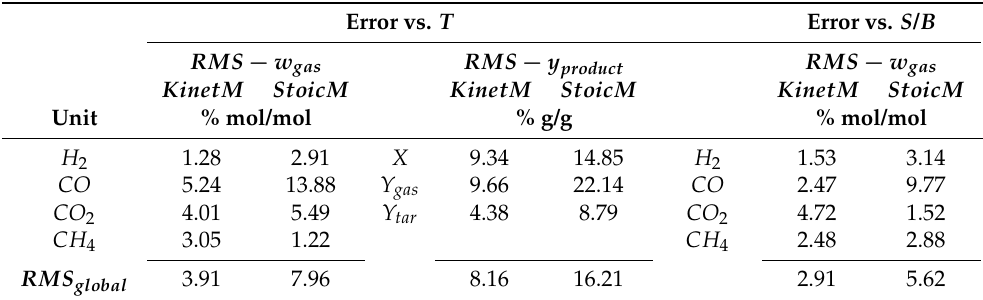
Table 7. The errors RMS of models StoicM and KinetM in the prediction of the syngas composition ( w gas , i ) and mass yield of the products ( y product , i ) when evaluating T and S / B . Error vs. T Error vs. S / B RMS − w gas RMS − y product RMS − w gas KinetM StoicM KinetM StoicM KinetM StoicM Unit % mol/mol % g/g % mol/mol H